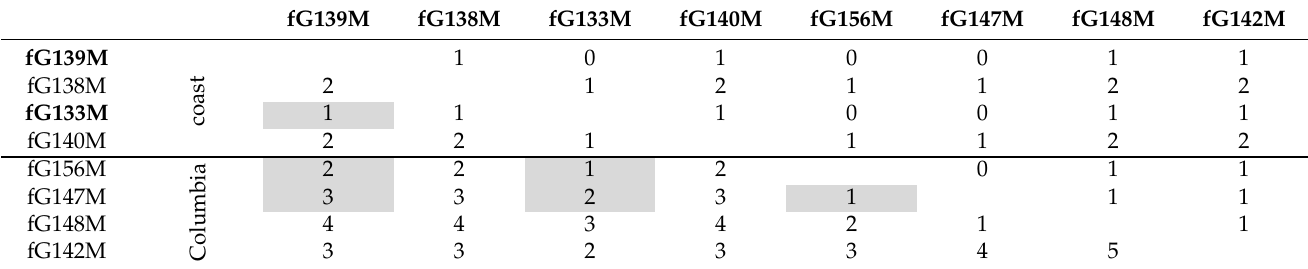
Table 5. Pairwise comparisons of all fullG types found among third (mG139M) emergence. Nucleotide differences are on the lower half of the matrix, and amino acids are in the upper half. Genotypes are listed according to which coast or Columbia region they were detected in, except for bold text genotypes, which occurred in both. Cells highlighted in grey indicate nucleotide differences that are silent. Sequences containing heterogeneous base identities are not